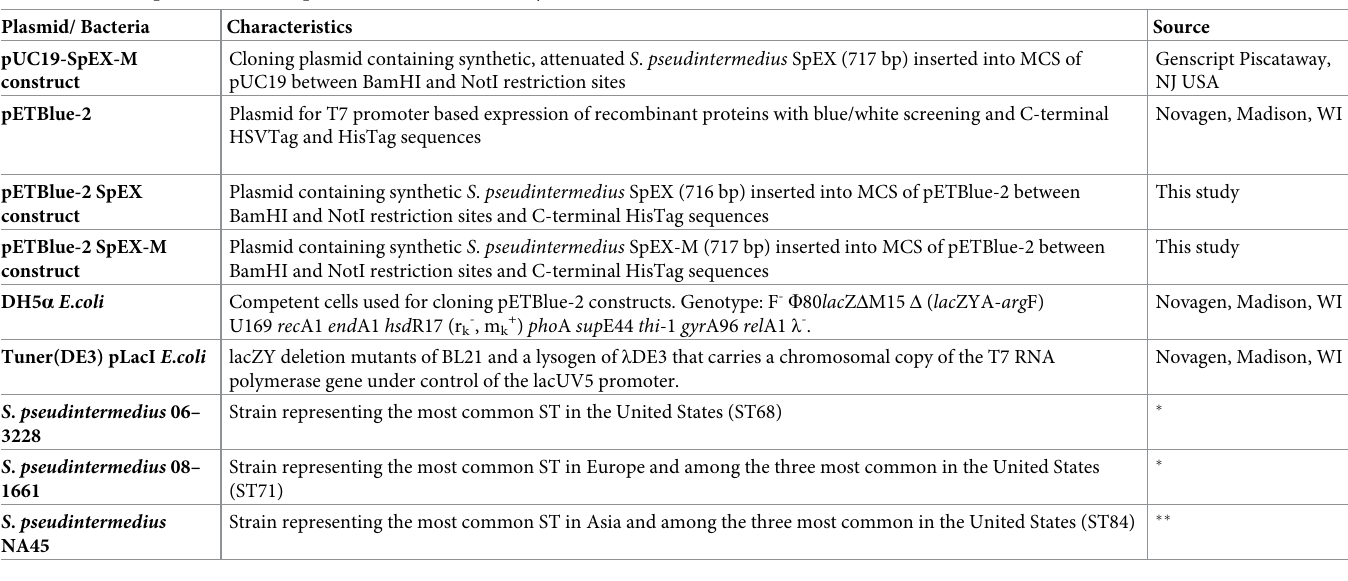
Table 1. Bacteria, plasmids and competent cells used in this